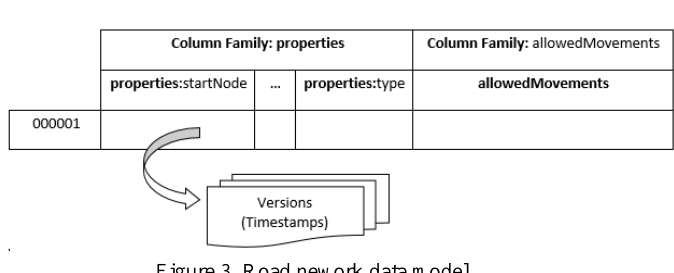
Figure 3. Road nework data